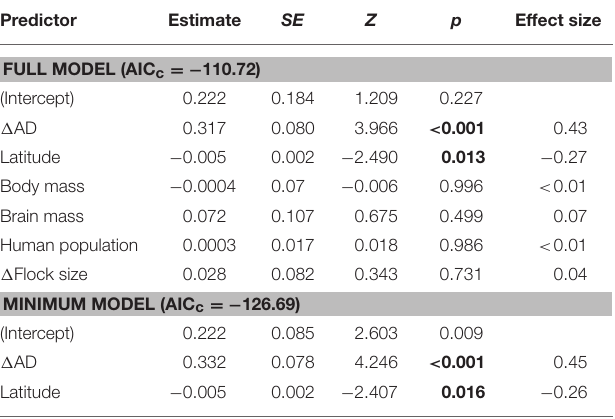
TABLE 3 | Full and minimum adequate models explaining the rural-urban differences in buffer distance ( 1 buffer- 8 ) of European birds. Predictor Estimate SE p Effect size